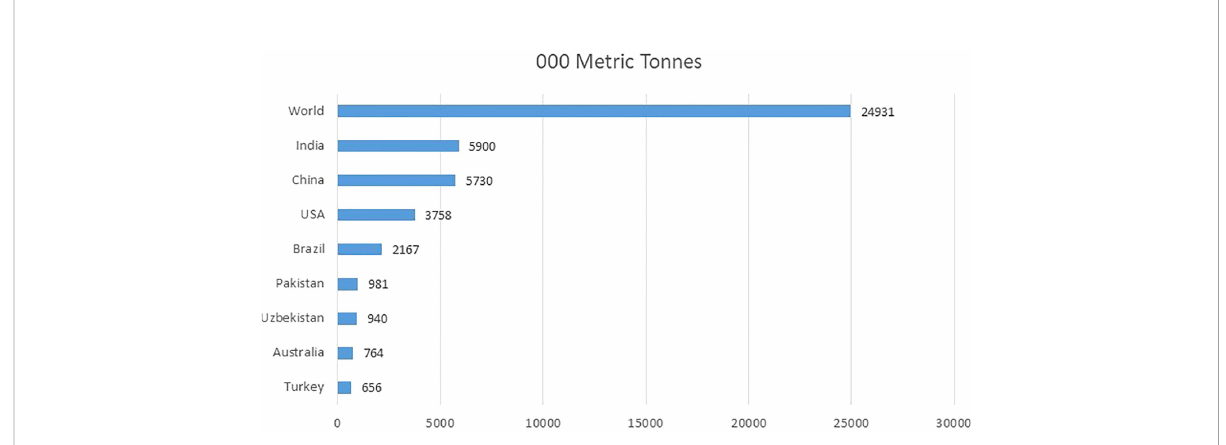
FIGURE 1 Top cotton producing countries worldwide in 2021-2022 (in 1,000 metric tons) (International Cotton Advisory Committee,